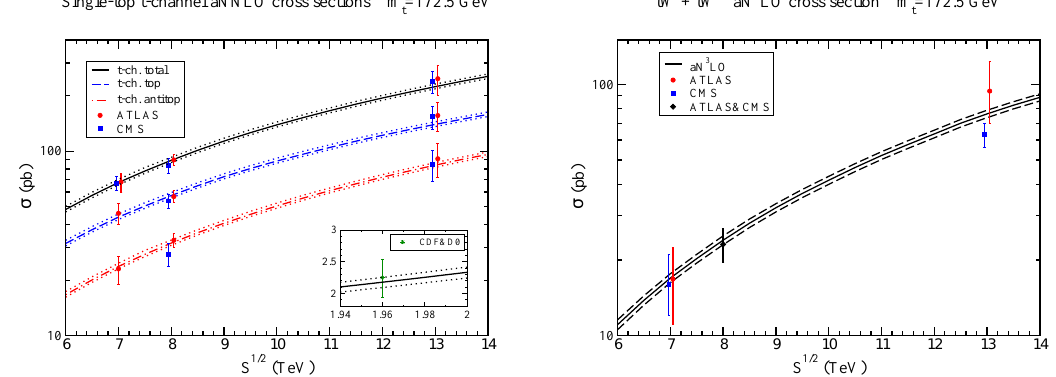
Figure 3. ( Left ) single-top t -channel aNNLO cross sections compared with CMS and ATLAS data at 7 TeV [23,24], 8 TeV [25,26], and 13 TeV [27,28], and with CDF and D0 combined data at 1.96 TeV [29]; ( Right ) aN 3 LO cross sections for tW production compared to ATLAS and CMS data at 7 TeV [30,31], 8 TeV [32], and 13 TeV